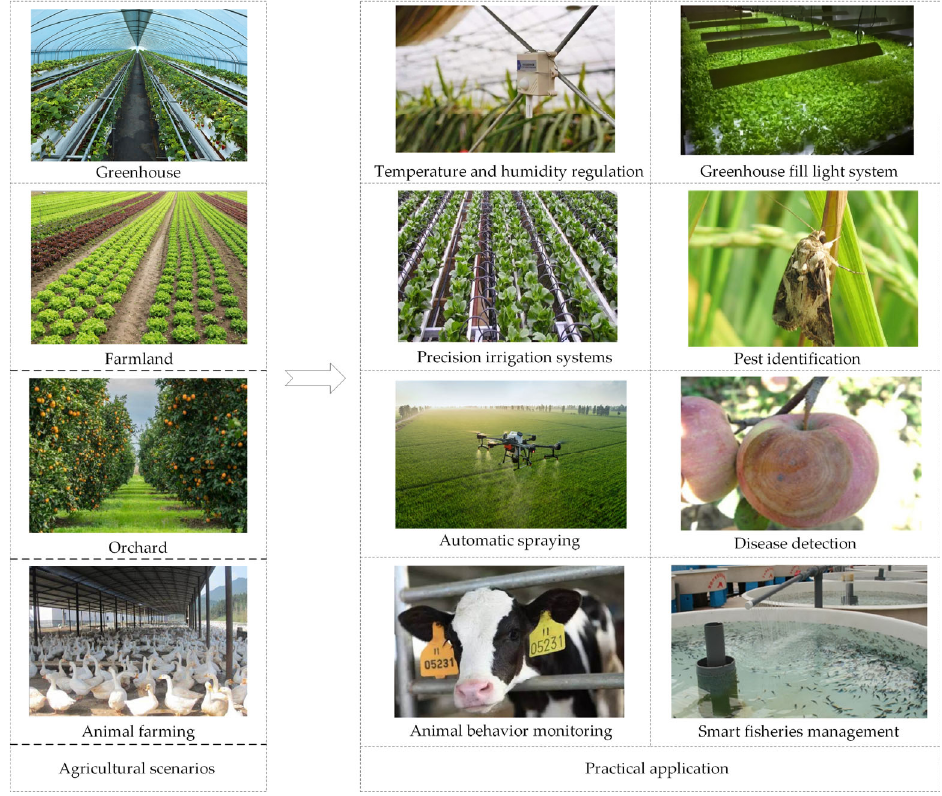
Figure 2. Practical applications of IoT in agriculture.